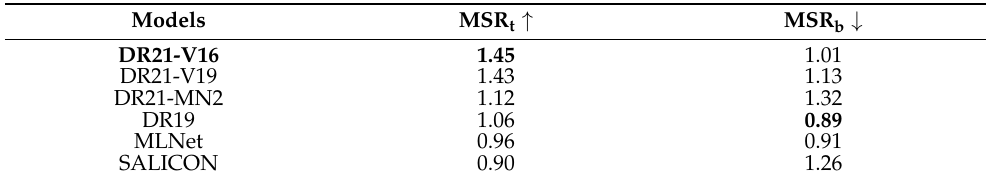
Table 9. SALICON, MLNet, and DeepRare family ( DR19 and DR21 with MobileNetV2, VGG19, and VGG16 architectures) results on the O 3